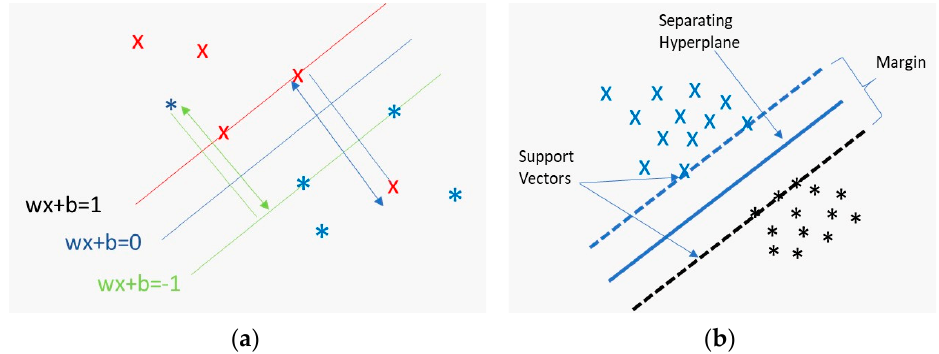
Figure 7. SVM classifier: ( a ) Projection of data points to compute the distance to a hyperplane [46]. ( b ) Illustration of the maximum margin between support vectors to separate between different classes [46].